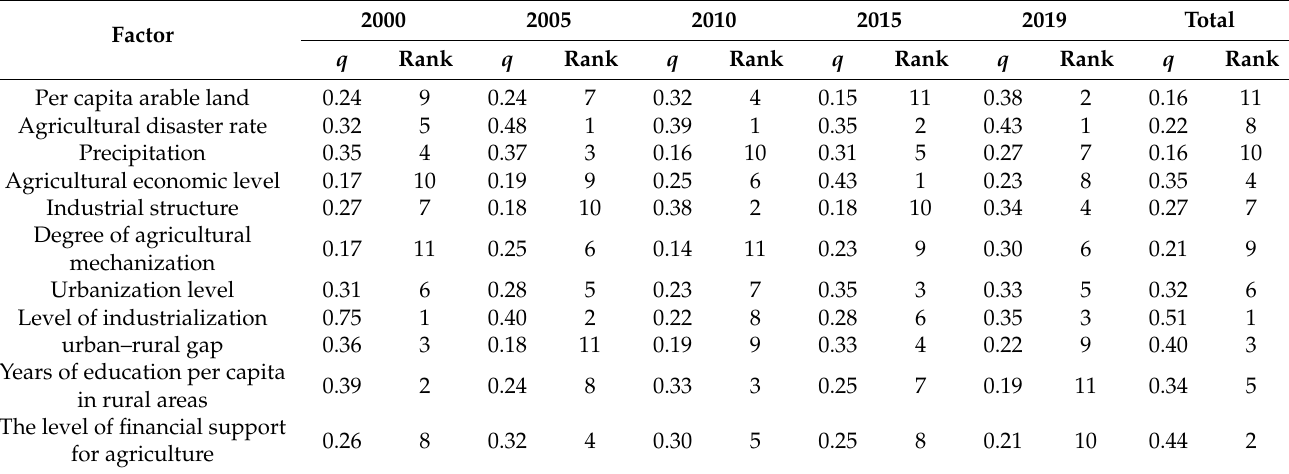
Table 4. Factor detection results of the spatial differentiation of AEE in